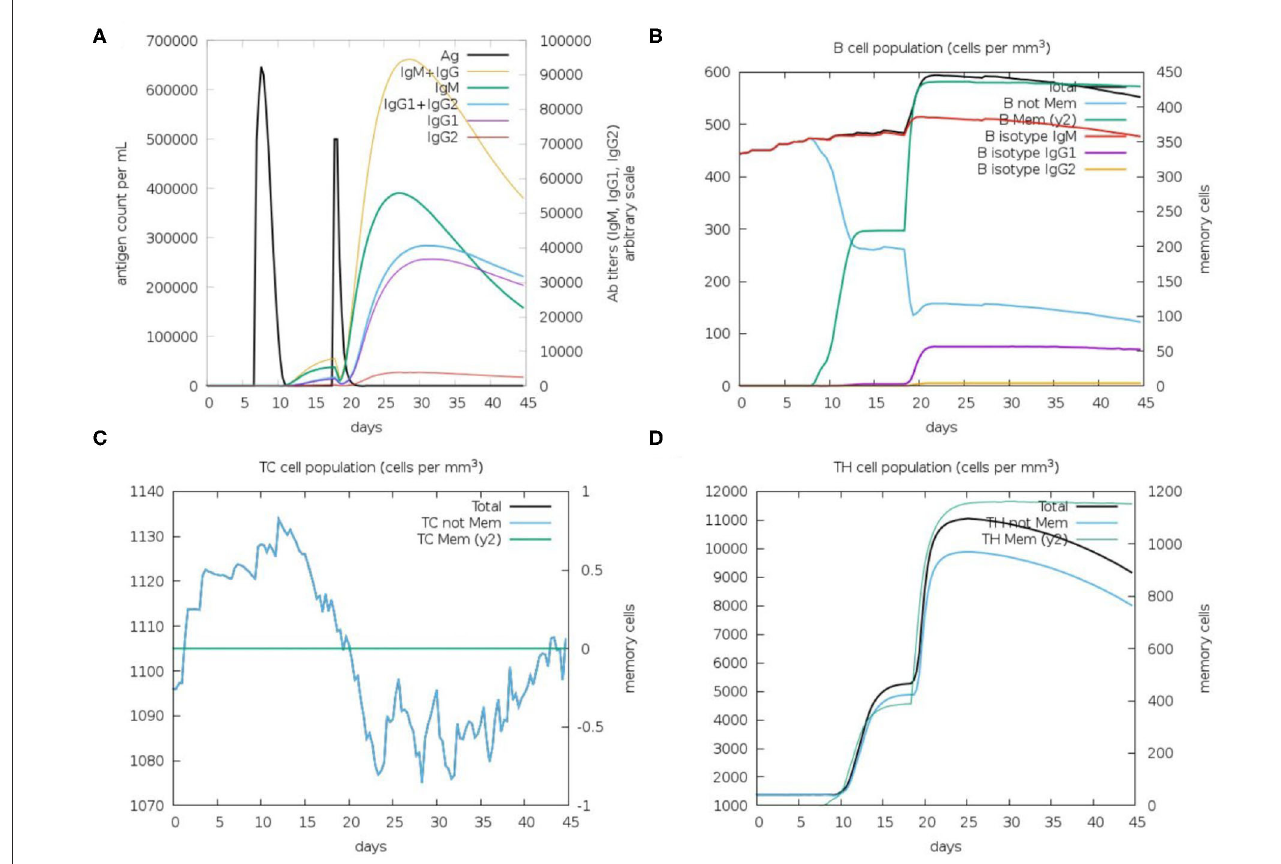
FIGURE5 C-ImmSim in silico immune simulation analysis, showing immune response against IBDV-MEV construct. (A) Immunoglobin production (colored peaks) in response to vaccine injections (black; 7 and 18 Day); (B) Amount of B lymphocytes composed of B memory (y2) and B-isotypes (IgM, IgG1, and IgG2) (C) CD8 + T-cytotoxic lymphocytes (CTL) cell populations and (D) CD4 + T-helper lymphocytes (HTL) cell population; per state in response to antigen